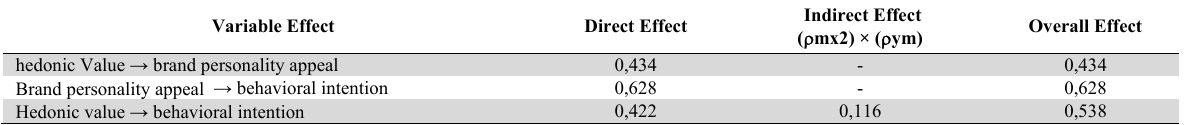
Direct and Indirect Effect as well as Overall Effect of hedonic value (X 1 ), brand personality appeal (X 2 ), and behavioral